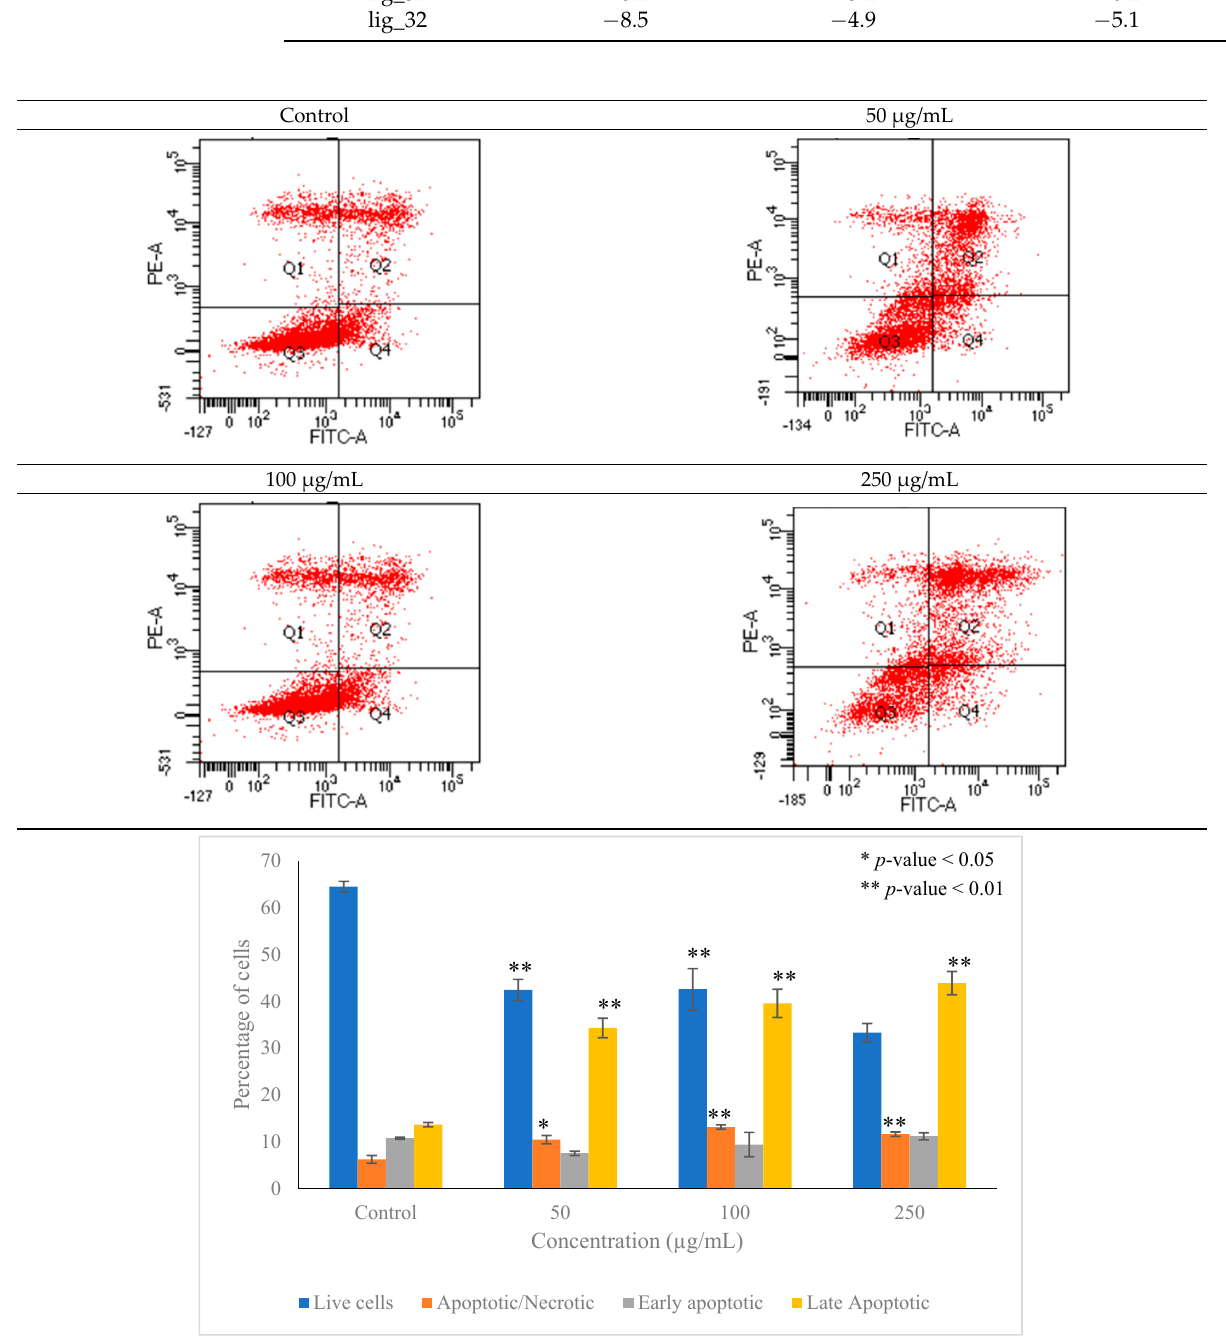
Figure 8. Cellular apoptosis evaluated using Annexin V/PI double staining by flow cytometry. The apoptosis rate of cells was significantly increased in cells treated with EEPO as compared to control cells. Apoptotic cell percentage was quantified after treating the cells with various concentrations of EEPO ranging from 50 to 250 μ g/mL. The results were analyzed using two-way ANOVA; data are expressed as mean ± standard deviation (SD), n = 3. The significance is represented as * p < 0.05, ** p < 0.01.